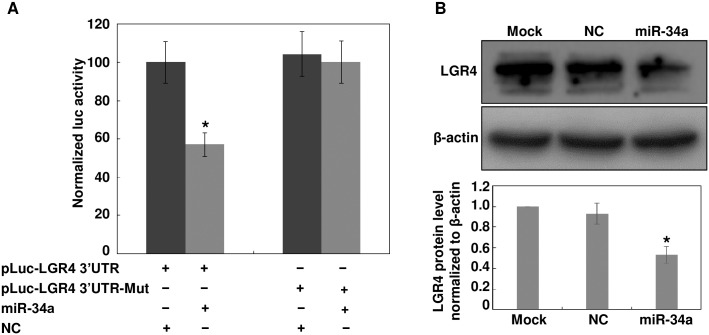
LGR4 is a direct target of miR-34a.(A) HEK293 cells were co-transfected with miR-34a, pMIR-LGR4 3’-UTR or pMIR-LGR4 3’-UTR-Mut, along with a pRL-SV40 reporter plasmid. After 24 hours, the luciferase activity was measured. Values are presented as relative luciferase activity after normalized to Renilla luciferase activity. Results are expressed as mean ± SD. n = 3, *p < 0.05. (B) ARPE-19 cells were transfected with either miR-34a or a negative control (NC). Cell lysates were prepared and used for Western blot analysis of LGR4. β-actin was probed as loading control. The band intensity was measured with ImageJ software. Images are representative of at least three independent experiments.